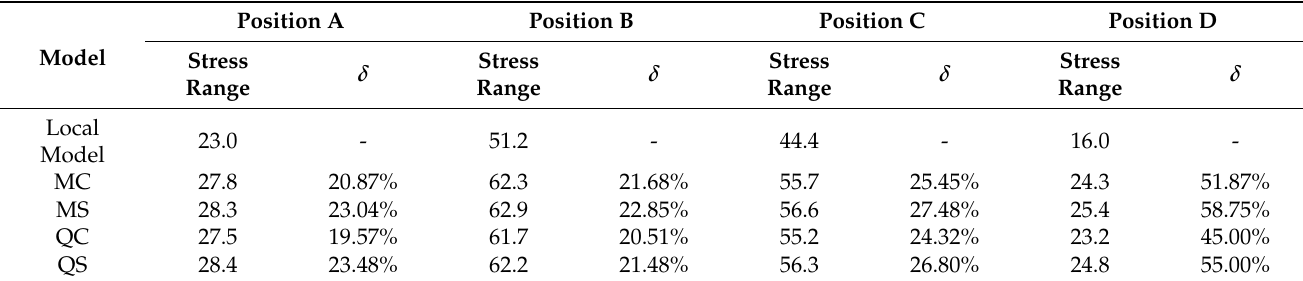
Table 2. Stress results of the global model and the local model (unit: MPa).